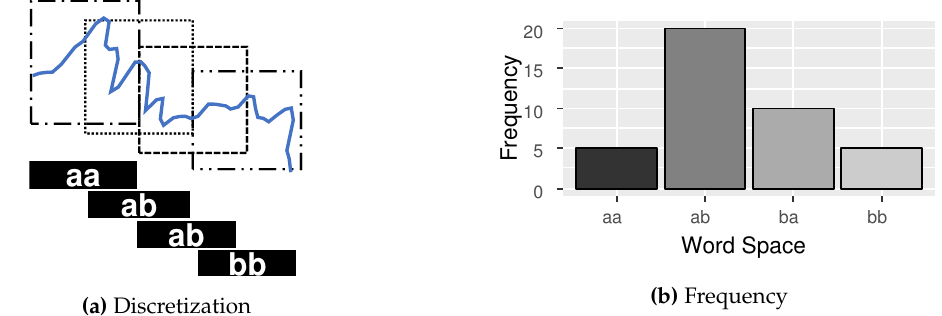
Figure 4. The discretization process of a time series to obtain a frequency distribution. The time series is segmented through the sliding window technique, and then discretized by some symbolic representation algorithm such as SAX or